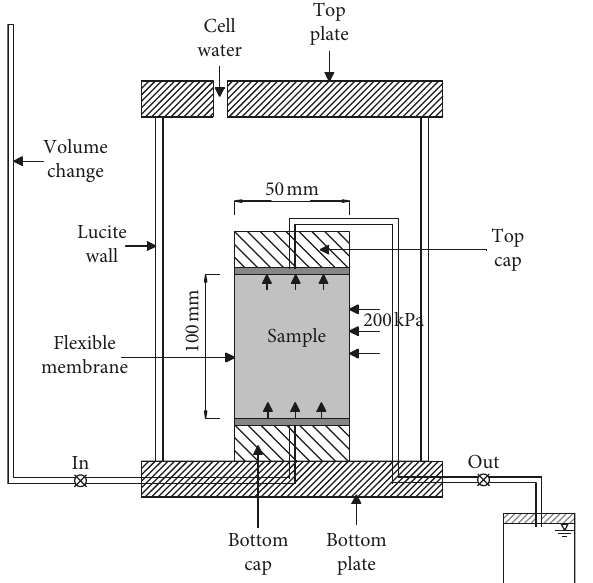
Figure 2: Schematic equipment